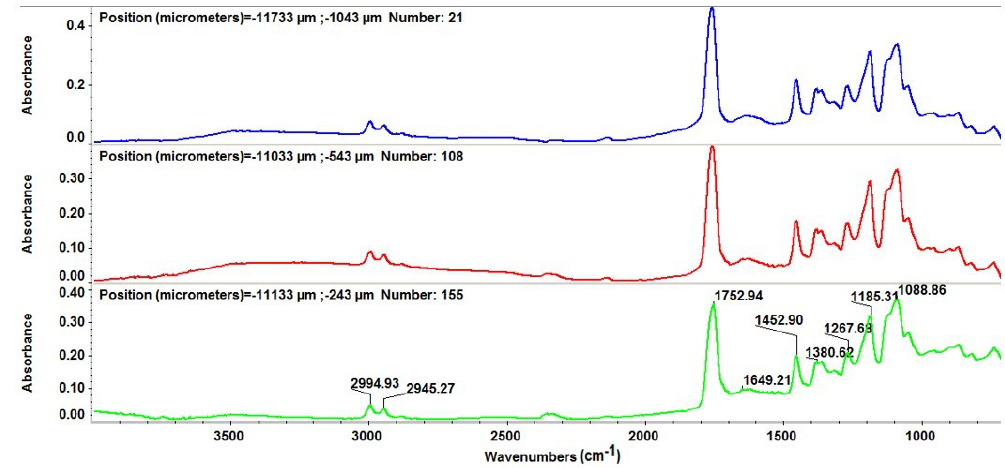
Figure 7. IR spectra of polylactic acid (PLA)/Fe 3 O 4 @EG